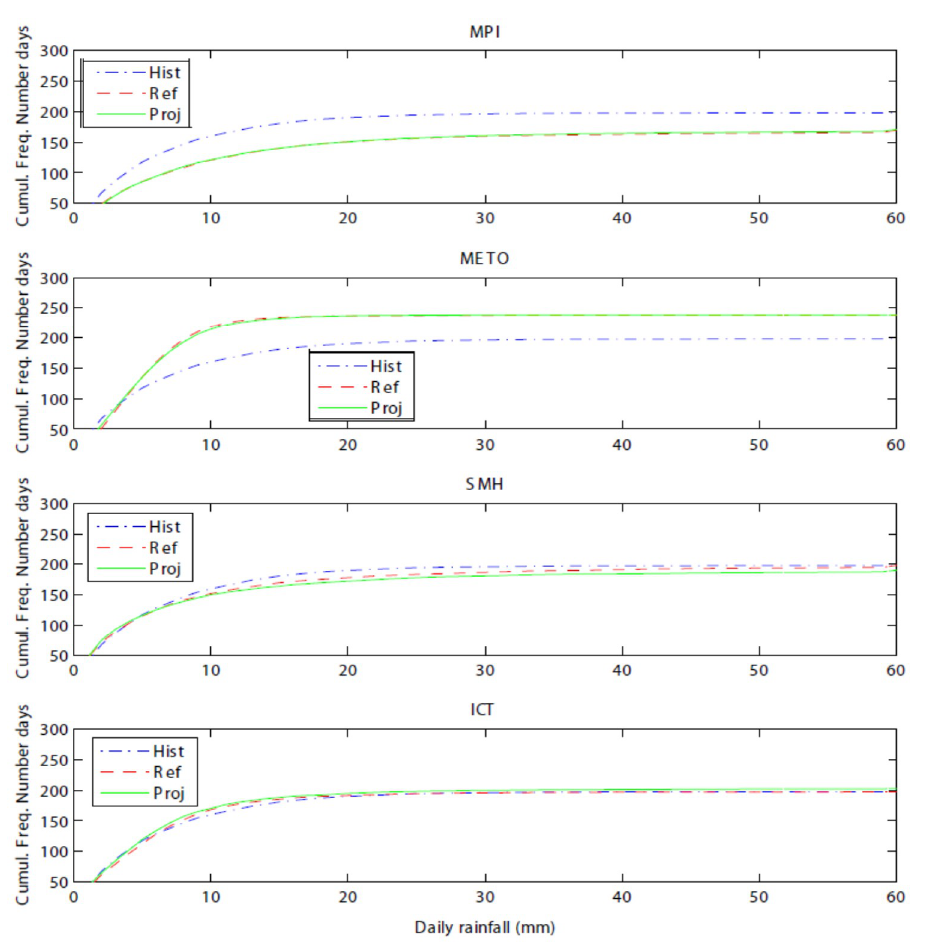
Figure 9. Cumulative distributions of daily precipitation from the four RCMs and comparison to observations (interpolated rainfall field). Cumul. Freq. Number Days = cumulative frequency of the number of days. NB: The empirical cumulative frequency of the number of rainfall days consists of adding up the sum of the number of days with more than 1 mm of rain.